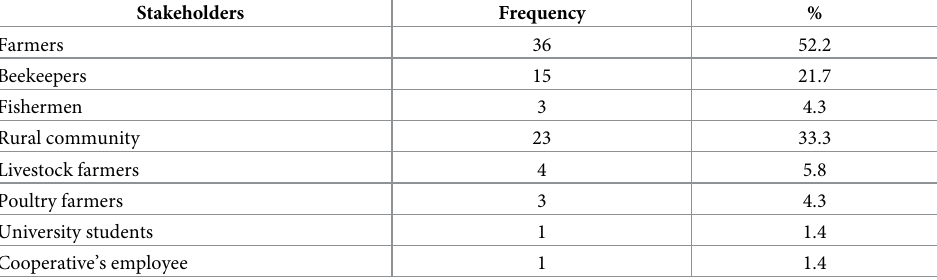
Table 4. Stakeholders of the